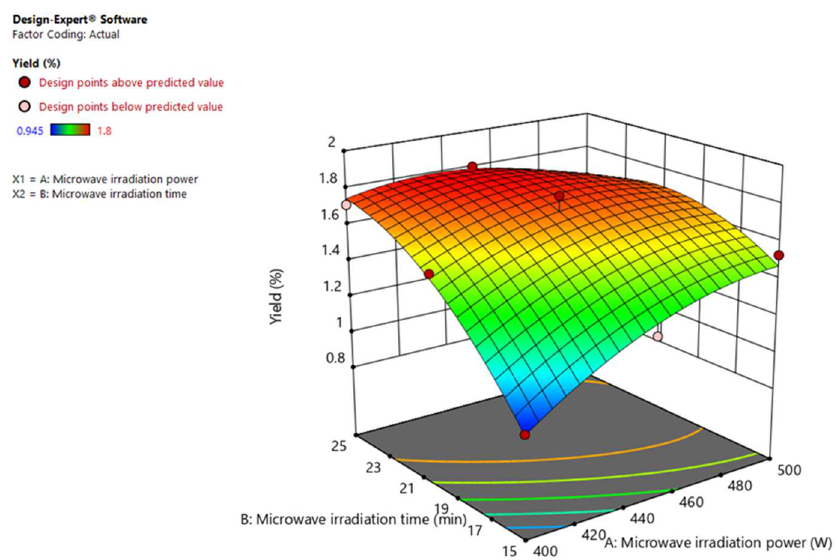
Figure 3. Three-dimensional response surface plots for the effect of microwave irradiation power and time on the yield of L. cubeba fruit essential oil.